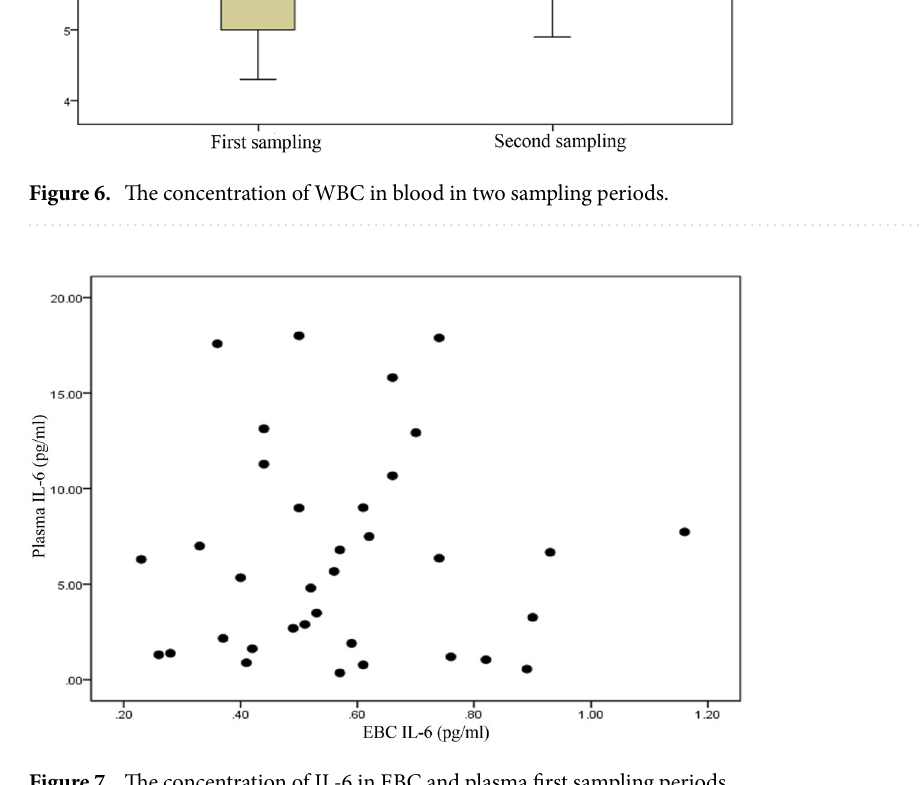
Figure 7. The concentration of IL-6 in EBC and plasma first sampling